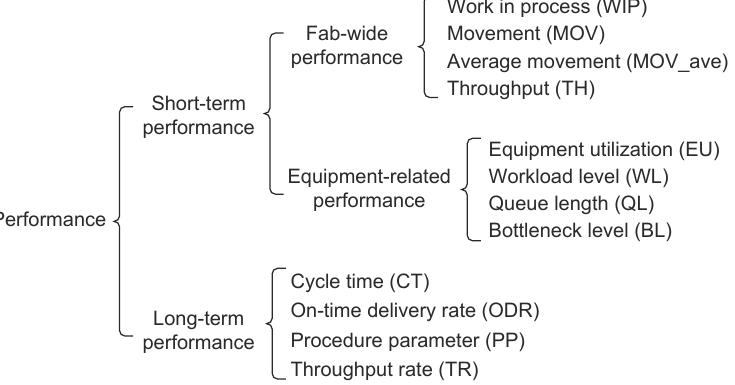
Fig. 3 Performance evaluation